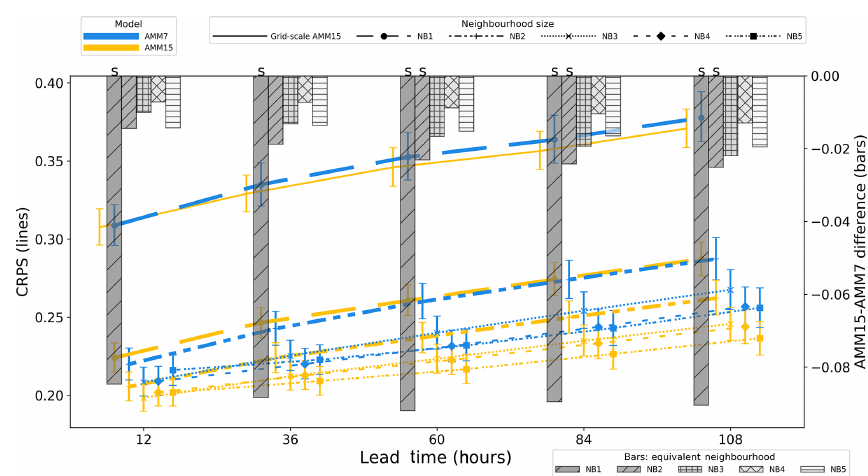
Figure 8. Summary of CRPS (left axis, lines) and CRPS difference (right axis, bars) for the January 2019 to September 2019 period for AMM7 and AMM15 models at different neighbourhood sizes. Error bars represent 95% confidence intervals generated using a bootstrap with replacement method for 10000 samples. An “S” above the bar denotes that 95% error bars for the two models do not overlap.